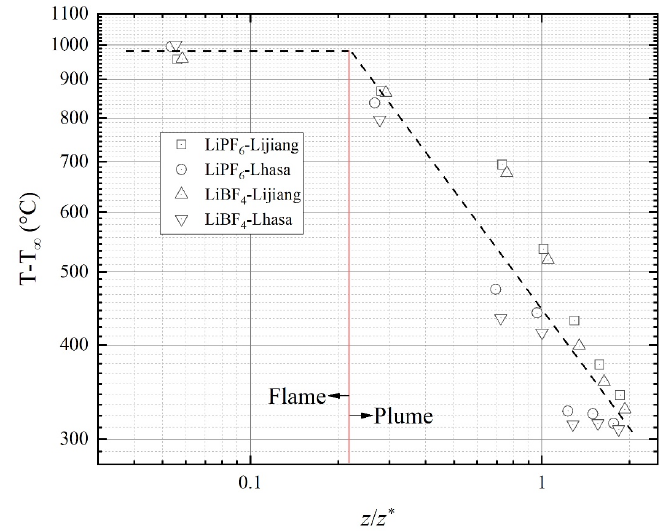
Figure 6. The average fire centerline temperatures with different heights of the two samples under different pressures during the stable combustion stage.